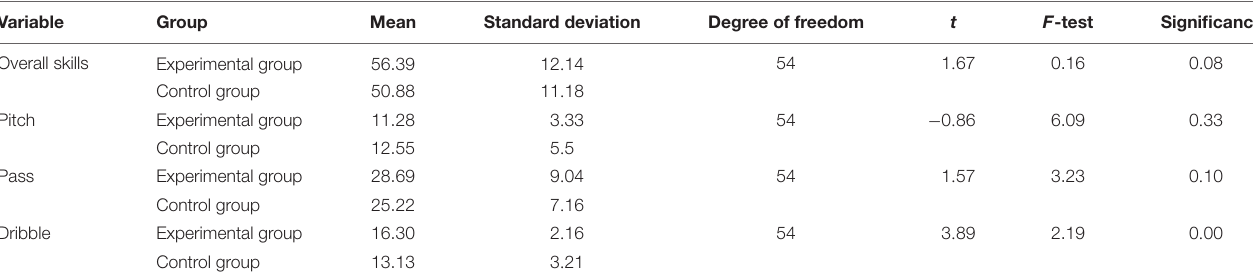
Pass Experimental